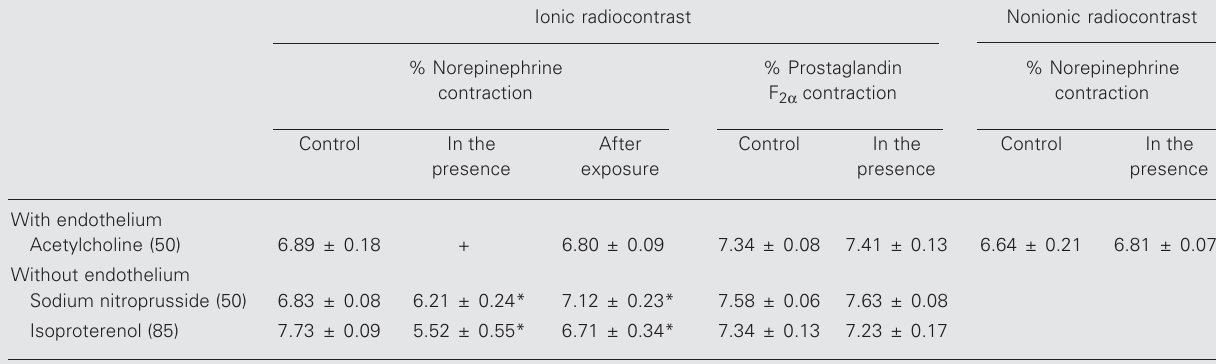
+ Rings were relaxed less than 50% of norepinephrine contraction. The numbers in parentheses indicate effective dose (ED) values. *P < 0.05 compared to control